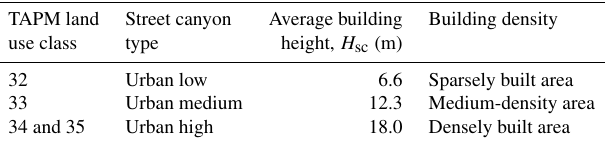
Table 2. The geometry of three generic street canyon types in City- Chem. For street canyons of type “urban medium”, H sc is taken as the mean value of “urban low” and “urban